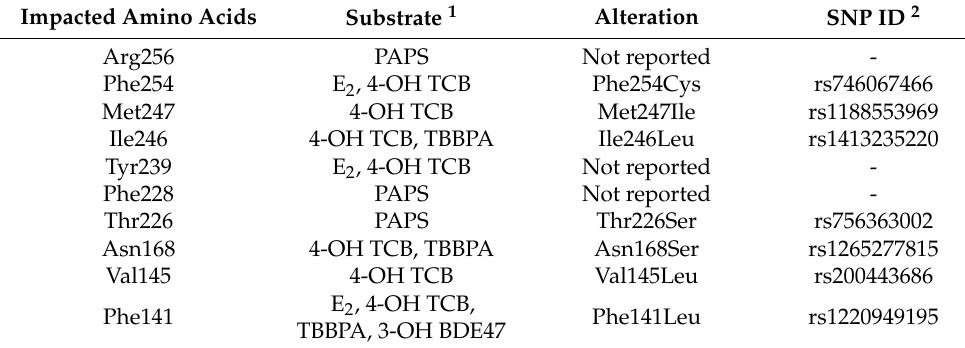
Table 6. Amino acids near to substrate-binding sites of